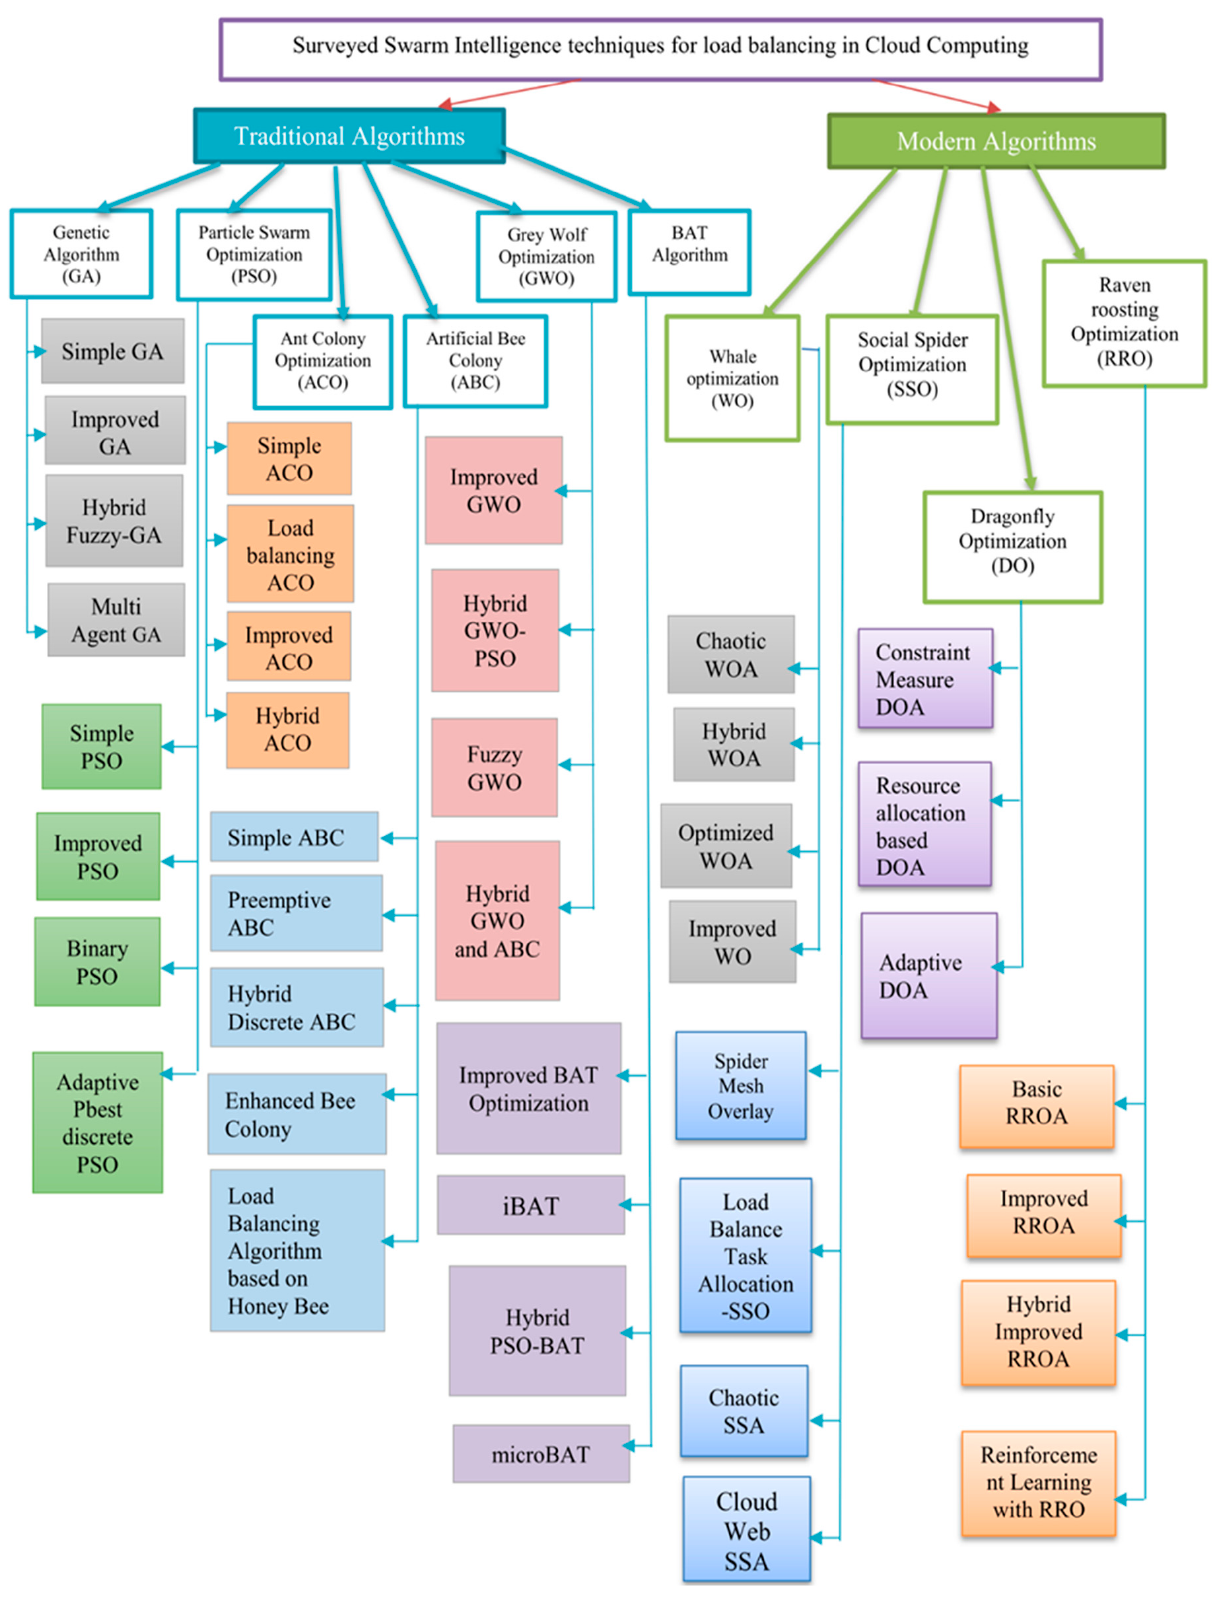
Figure 4. Swarm intelligence algorithms under discussion.